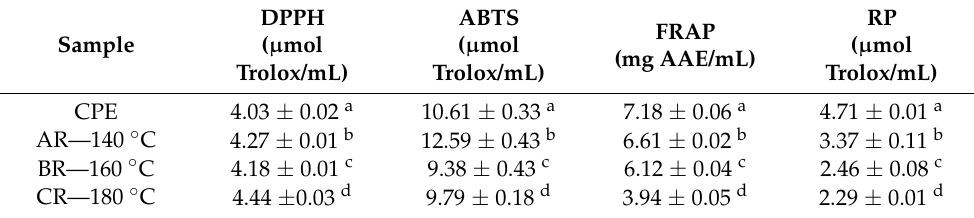
Table 5. Antioxidant potential of Camelina Press Cake Extract before and after reconstitution.